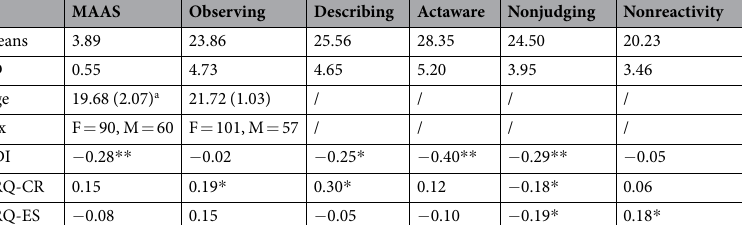
F = 90, M = 60 F = 101, M = 57 /